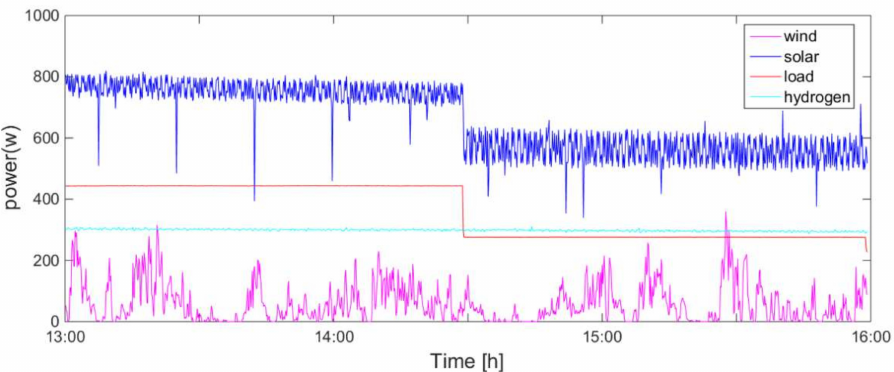
Figure 14. Power curves in scenario 2 (restricted